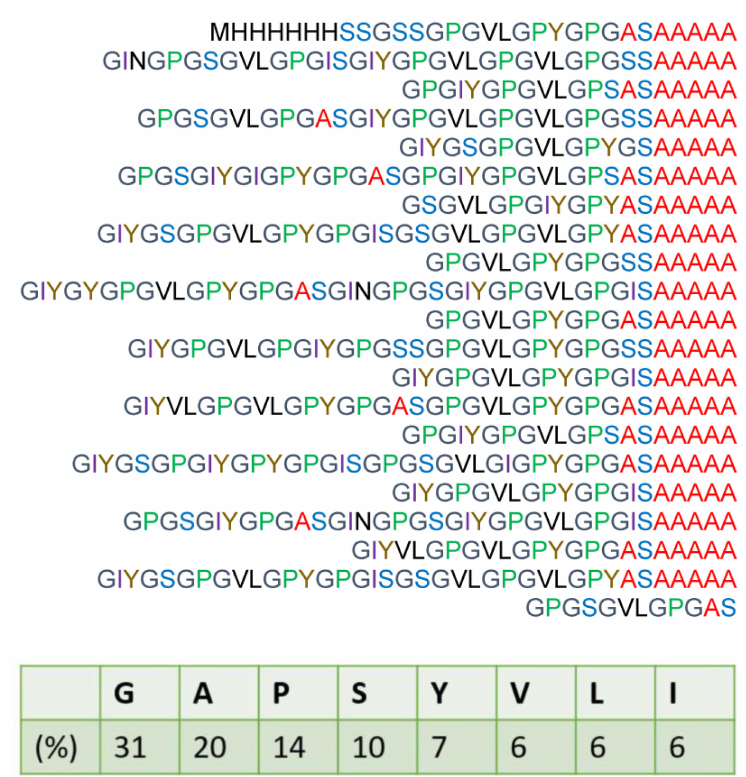
Figure 1. Amino acid composition and primary structure of recombinant spider silk protein RSSP(VLI) based on the primary sequence of ADF‑3 Araneus diadematus silk protein with the Gln site replaced by Val, Leu, and